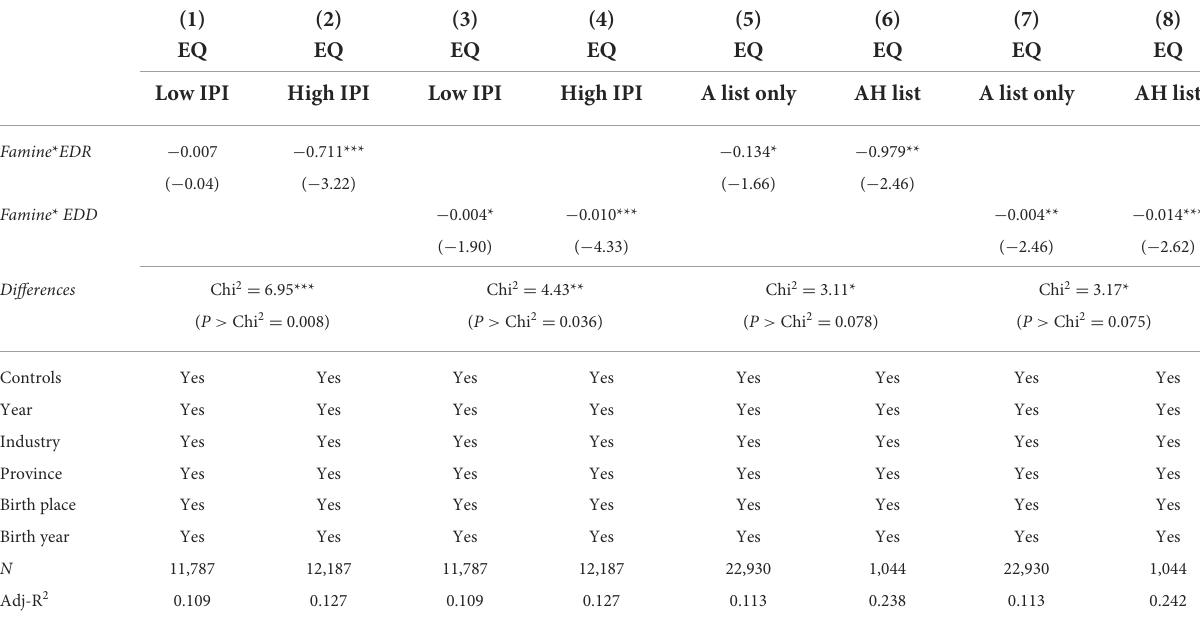
TABLE 12 CEO famine experience and quality of corporate earnings—a test of risk aversion